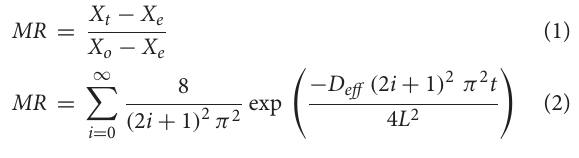
Fick’s second law was also used for long time periods and thin- layer in one dimension (Eq. 2) which leads to Eq. (3), representing the first term in the development of the series, from which the diffusional coefficient is obtained for each drying process (Lemus-Mondaca et al., 2015). The equilibrium moisture content ( X e ) was determined experimentally by monitoring the weight and calculating the leaves moisture content using an analytical balance (Chyo, modelo JK-200) and from the calculation of the absolute value between two consecutive moisture measurements